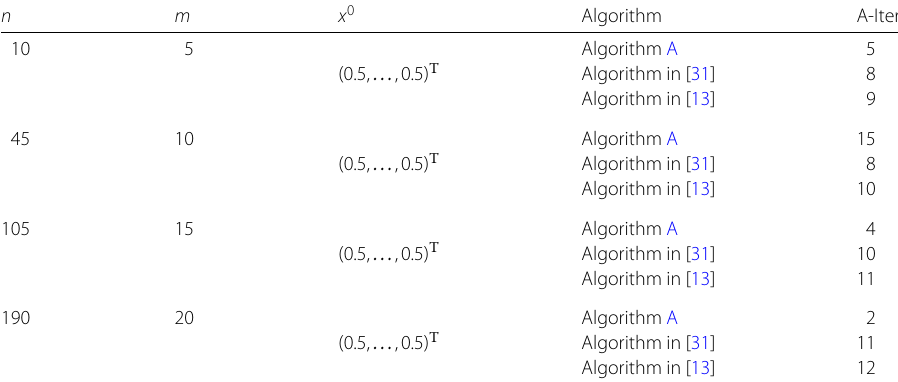
Table 2 Numerical results of